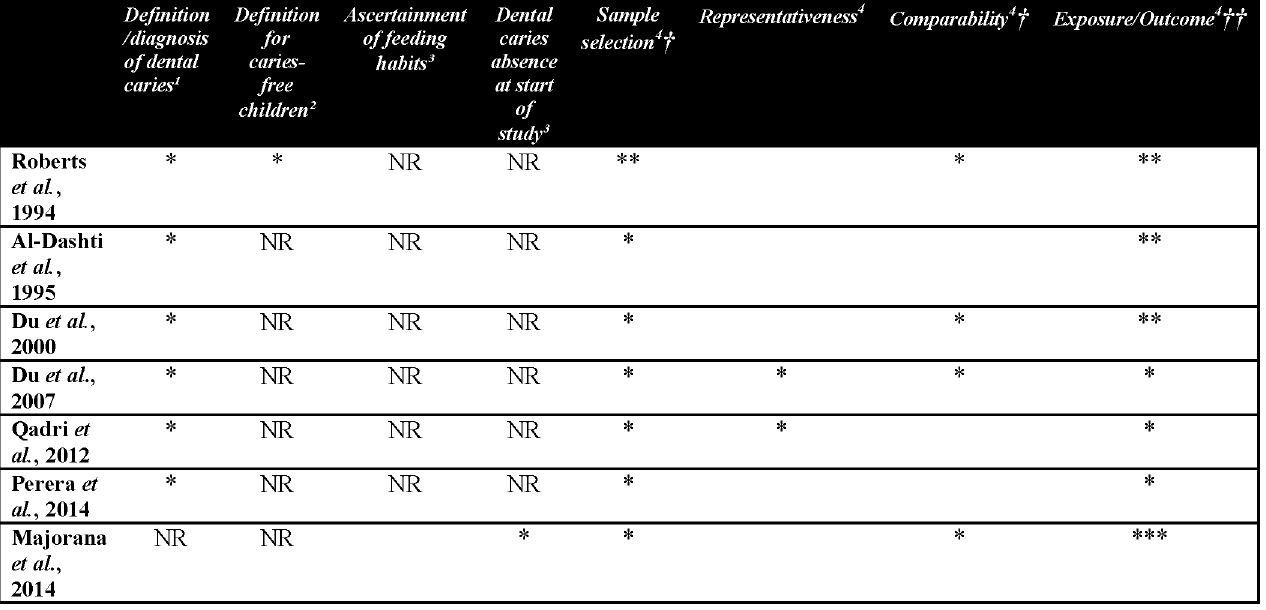
Fig 2. Newcastle-Ottawa quality assessment summary. 1 For cross-sectional and case-control studies. 2 For case-control study only. 3 For cohort study only. 4 For all study designs. † This item was allocated a maximum of 2 points. †† This item was allocated a maximum of 2 point for cross-sectional and 3 points for cohort and case-control studies. NR = not